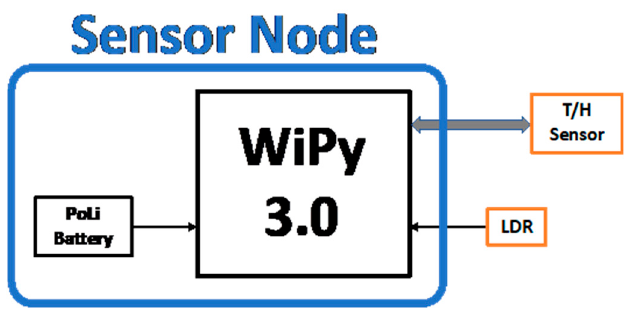
Figure 3. Sensor node architecture diagram.